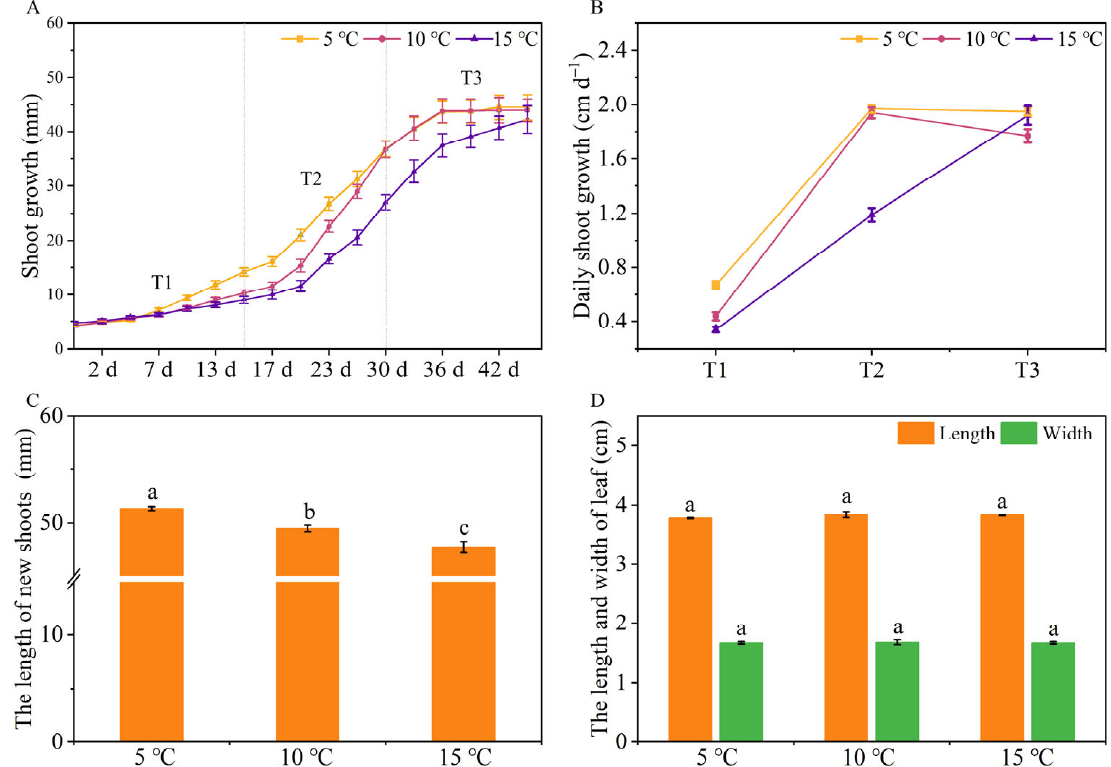
Figure 1. The effects of different DIFs on tea plant growth. ( A ) The length of the new shoots; ( B ) The daily growth rate of the shoots at each stage; ( C ) The length of one bud with three leaves; ( D ) The length and width of the third leaf. Different letters indicate treatments that are significantly different at p < 0.05 ( n = 3).